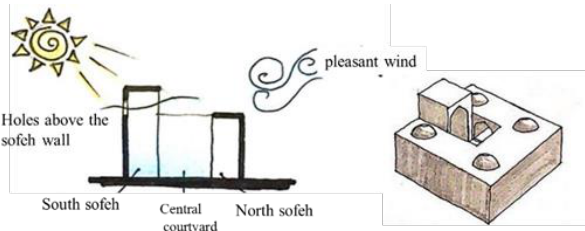
Figure 15. Function of the South sofe as a Wind catcher mansion.